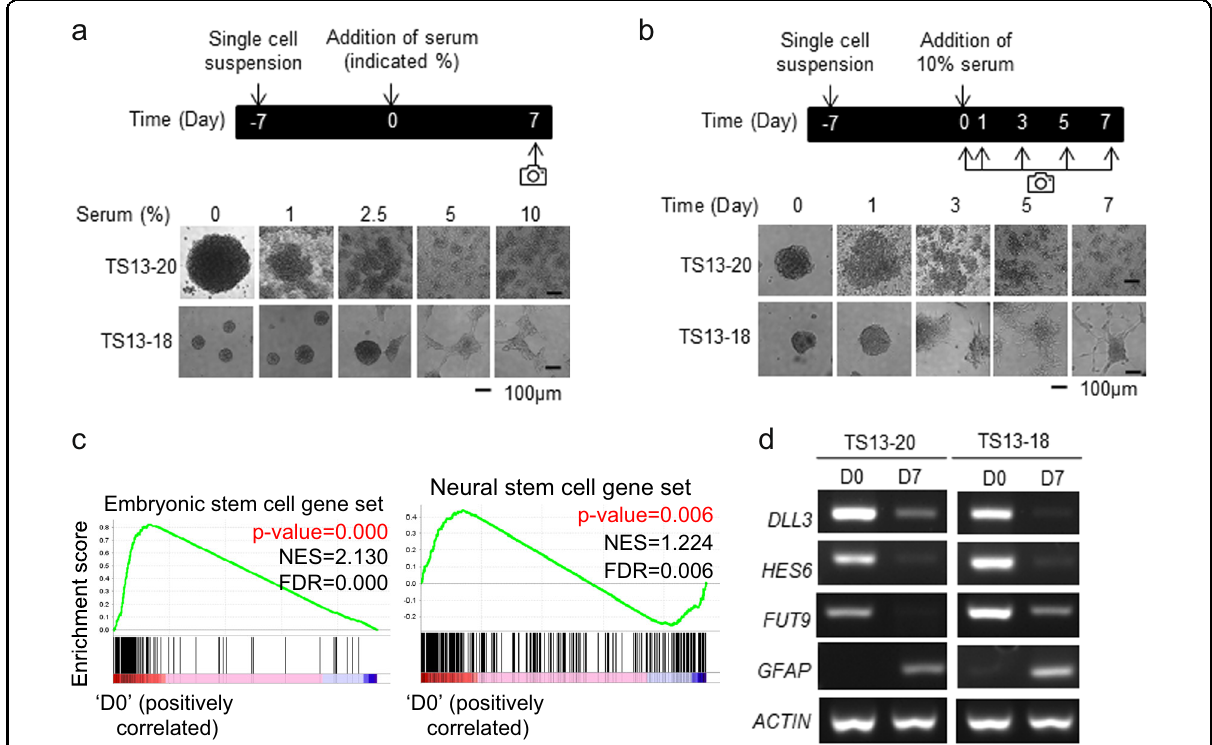
Fig. 1 Patient-derived glioblastoma sphere cells are enriched in the stem cell signature. a , b Serum-induced differentiation of patient-derived glioblastoma sphere cells. Bright fi eld image of cells taken using a Cytation 3 microplate reader (Bioteck) after the addition of ( a ) various concentrations of serum for 7 days and ( b ) 10% serum for the indicated number of days; a representative image of at least three independent experiments is shown. c The expression level of total RNA from TS13-20 spheres (D0) and their differentiated counterparts (D7) that were treated with 10% serum for 7 days was determined by RNA sequencing. Gene set enrichment analysis (GSEA) showed that sphere cells were enriched in neural stem cell and embryonic stem cell gene signatures. (NES: normalized enrichment score, FDR: false discovery rate). Gene sets are listed